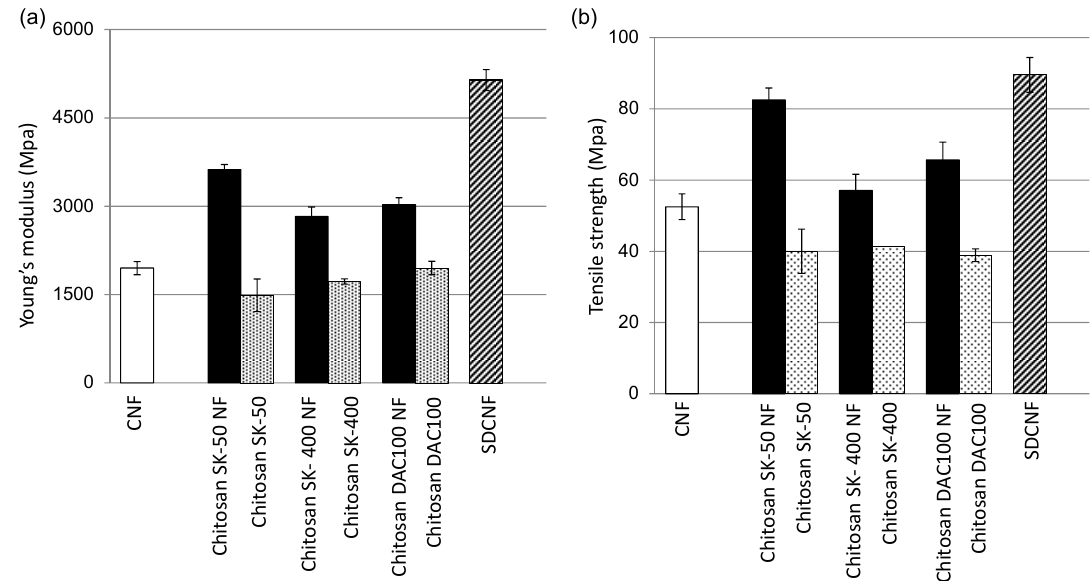
Figure 2. Mechanical properties of nanofiber (NF) sheets. ( a ) Tensile Young’s modulus of NF sheets and ( b ) fracture strength of NF sheets. CNF, chitin nanofiber; SDCNF, surface-deacetylated CNF.